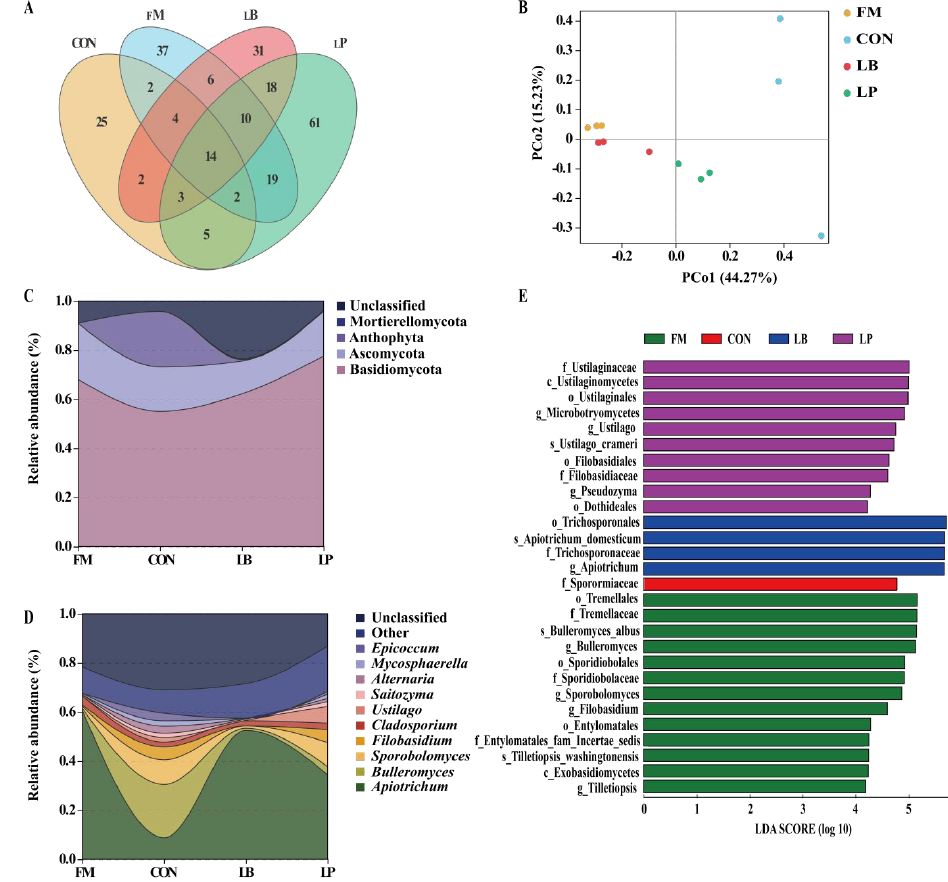
Figure 2. Fungal diversity and community structure in fresh materials and silages ( n = 3). ( A ) Venn diagram representing the common and unique ASVs found in fresh materials and silages. ( B ) Prin- cipal component analyses (PCoA) of samples conducted based on Bray UniFrac distance. ( C ) Streamgraph (%) of fungal phyla (1% at least in one group) of FM and forage oat silage at the phy- lum level. ( D ) The streamgraph (%) of bacterial phyla (1% at least in one group) of FM and forage oat silage at the genus level. ( E ) Significantly different genera with an LDA score greater than the estimated value (default score = 4). The length of the histogram represents the LDA score of different genera. FM - fresh material; CON , control treatment; LB , Lactiplantibacillus buchneri inoculated treat- ment; LP , Lentilactobacillus plantarum inoculated treatment. Letters indicate the taxonomy of the bac- teria: p , phylum, c , class; o , order; f , family; g , genus. 3.5. Association between Microbial Community and Fermentation Features in Forage Oat Silage In the current study, a heatmap was used to evaluate the correlations between the microbial genus (top 10) and fermentation profile based on the Spearman analysis (Figure 3). The LA content was significantly associated with Lactobacillus (rho = 0.967; p = 0.0002), and was negatively correlated with DM, NH 3 -N, pH, and WSC (rho = − 0.695, p = 0.038; rho = − 0.8, p = 0.013; rho = − 0.917, p = 0.001; rho = − 0.962, p < 0.0001; respectively).